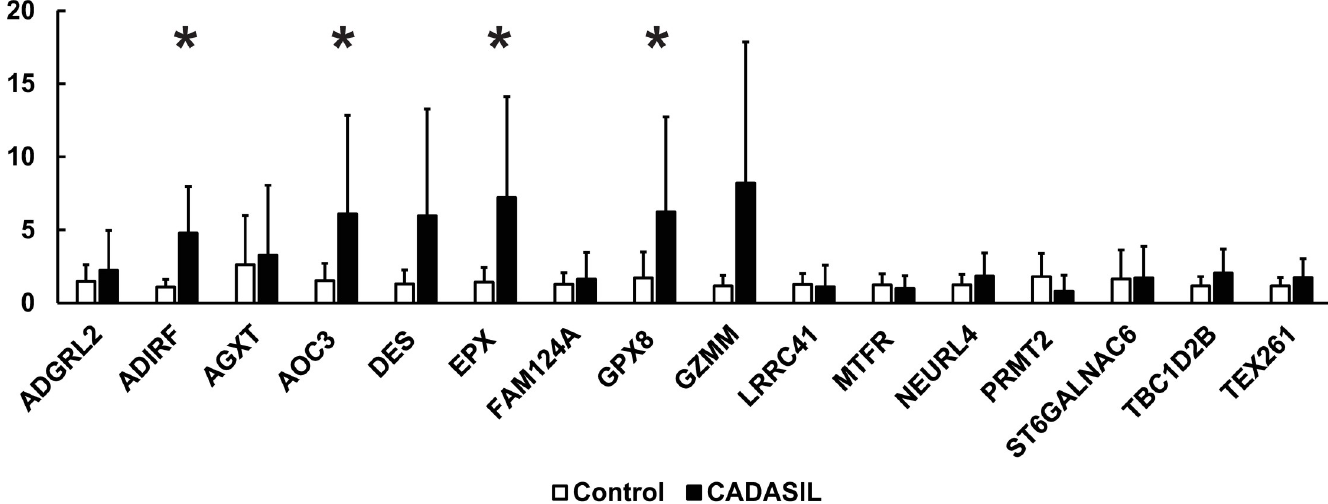
Fig 5. Quantification of mRNA of 16 markers in CADASIL and control brain. RNA from frozen frontal lobe of CADASIL and control brains were analyzed by qRT-PCR; expression values were normalized to 18S RNA and then controls were set to 1 (n = 8 per group; 37% female; average age at death was 62 years for controls and 64 years for CADASIL). X-axis show fold changes relative to controls. Significant differences with a p < 0.05 are denoted by asterisks.